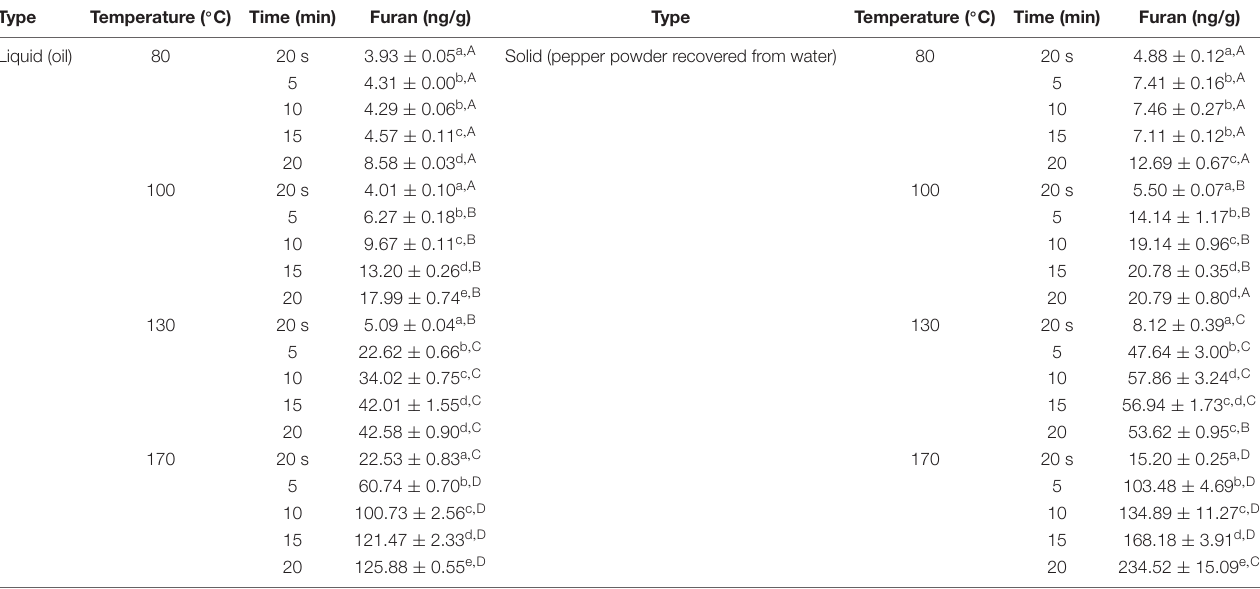
TABLE 3 | Furan concentration of fried red pepper and soybean oil samples. Type Temperature ( ◦ C) Time